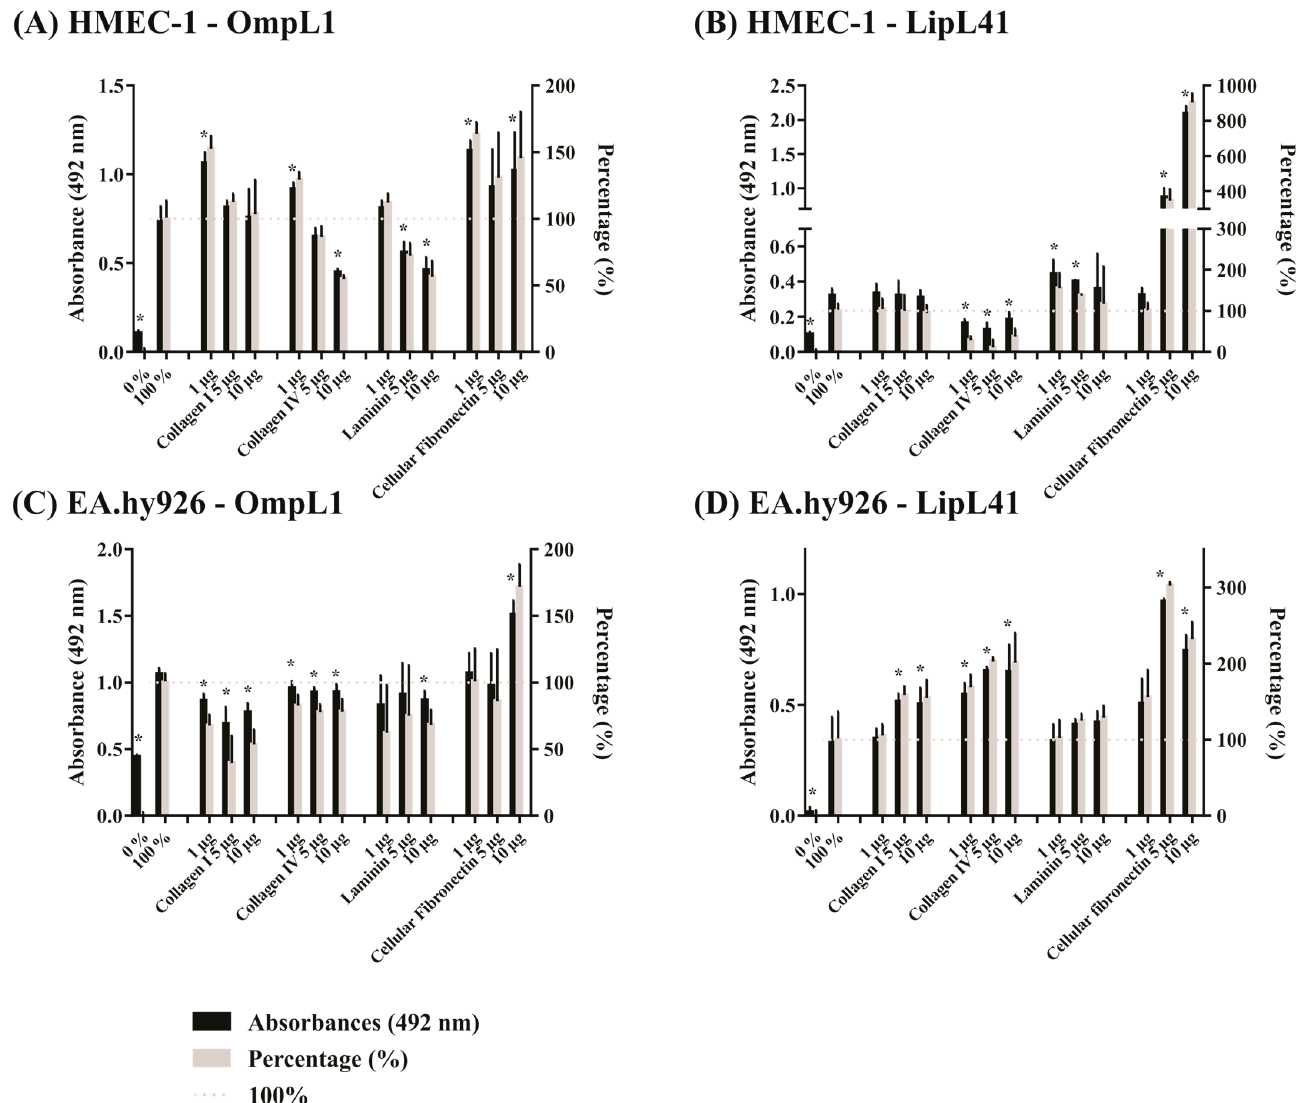
Figure 7. Competition assay between recombinant proteins and host components for binding to mammalian cells. Competition binding of the recombinant proteins and between the purified host components and cell receptors was assessed in 96-well plates with cell monolayers (10 5 cells/well). Proteins were incubated with different concentrations of host components and 1 µM aprotinin in cell media for 1 h. The samples were added to wells for 2 h. Samples without and with untreated recombinant proteins were used as controls. The polyclonal antibodies against the recombinant proteins (1:1000) were added for 1 h. Detection was performed with anti-mouse IgG-peroxidase. Values were represented by percentage considering the wells without and with the addition of untreated proteins as 0 and 100% of adhesion, respectively. The binding of the proteins was compared to the 100% control by the two-tailed t -test ( p < 0.05) showed by *. ( A ): HMEC-1–OmpL1, ( B ): HMEC-1–